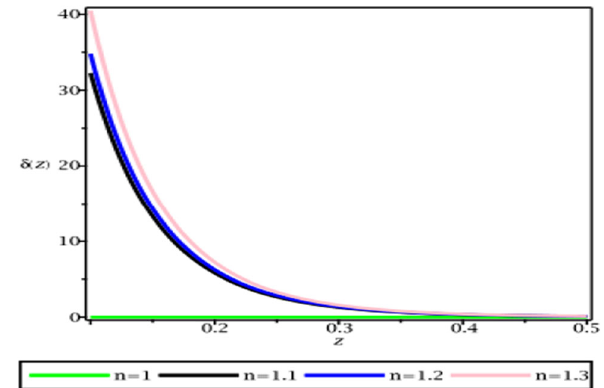
Fig. 2 The plots show the evolution of the energy-density fluctua- tions of dust given by Eq. (74) of the short-wavelength modes for α R + β R n model (black, blue and pink) together with Λ CDM case (green); for β = 0 . 00005, α = 0 . 001, Ω d = 0 . 32, Ω Λ = 0 . 68 and H 0 = 73kms − 1 Mpc − 1 . Note that there is a decrease of energy density perturbations with the increase of